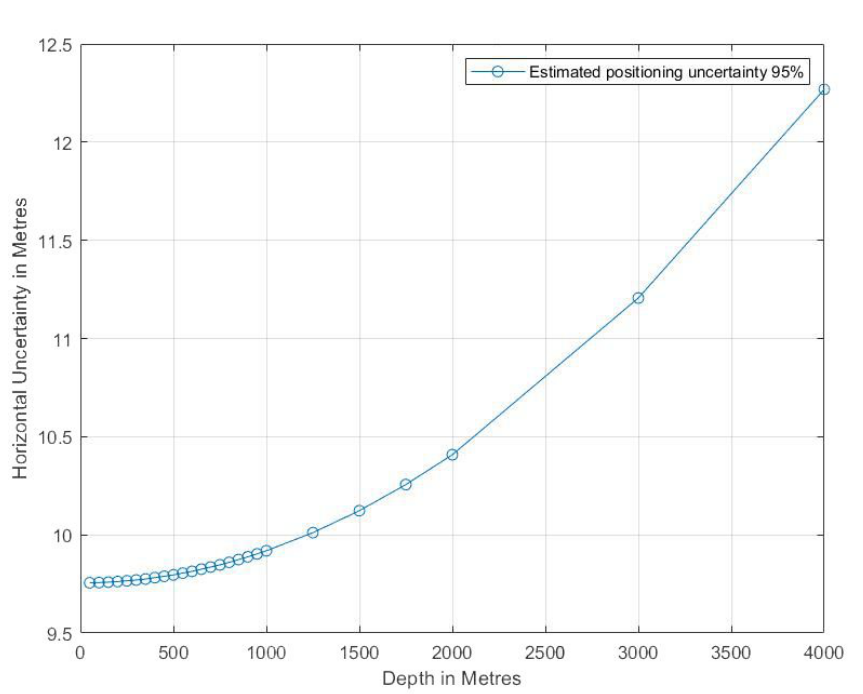
Figure 20. The total combined positioning uncertainty excluding the AINS uncertainty, 2 σ , assuming X < 50 m and Y = 1500